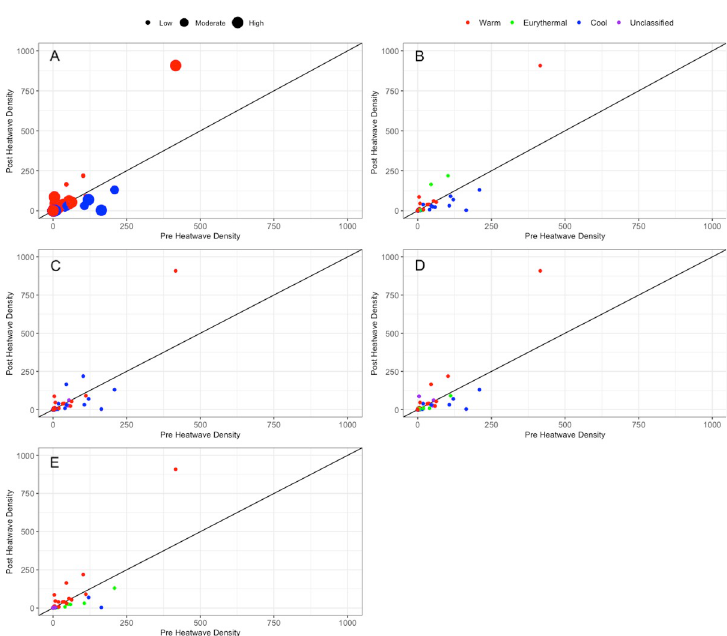
Fig 2. Variations in species response by classification metric. Scatterplots of individual species responses to the marine heatwave are shown with pre-heatwave (2012–2013 summed density) on the x axis and post-heatwave (2014– 2015 summed density) on the y axis. Points that fall below the black line are species that responded with density declines while points above the line experience density increases in response to the heatwave. Points are colored according to their classification (red for warm, green for eurythermal, blue for cool and purple for unclassified) for the A) composite classification B) expert opinion C) range limits D) museum Collections and E) diver surveys. In the composite classification, point size enlarge as agreement among classification data